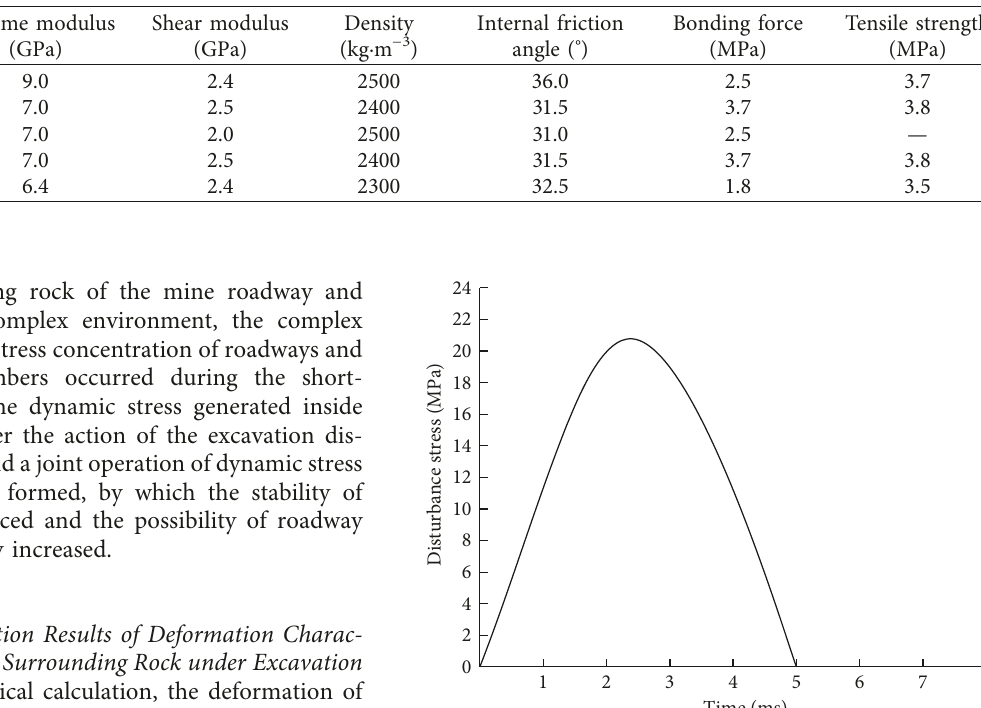
Table 2: Main rock mechanical parameters.